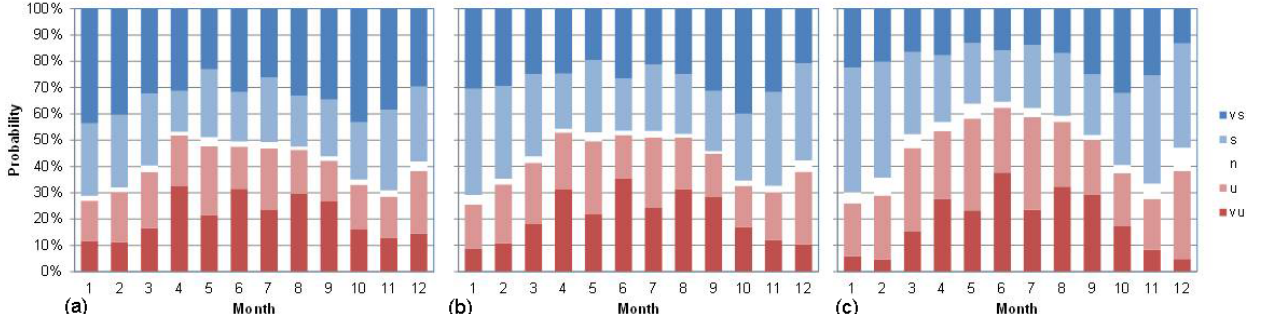
Figure 7. Monthly distribution of stability based on z/L obtained with the sonic anemometer at different heights: (a) 115.5m, (b) 75.5m and (c) 39.5m. vs, very stable; s, stable; n, neutral; u, unstable; vu, very unstable.